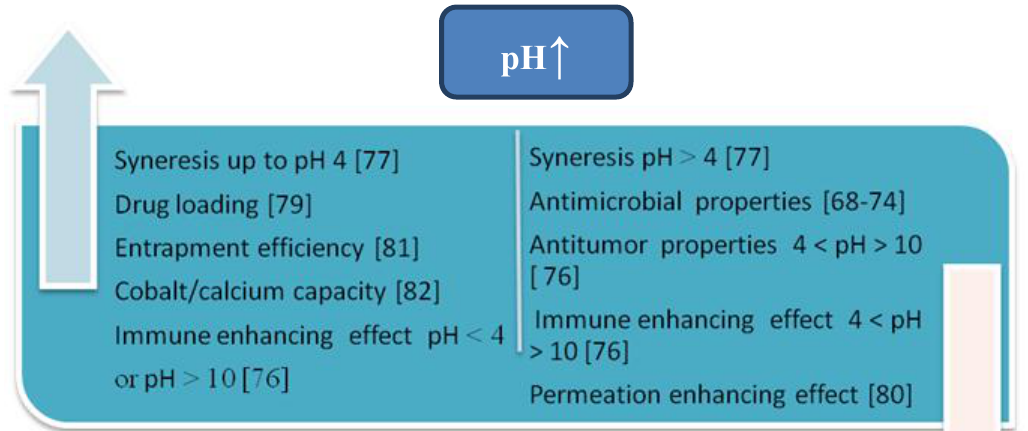
Figure 6. Influence of pH on the selected physicochemical and biological properties of chitin/chitosan